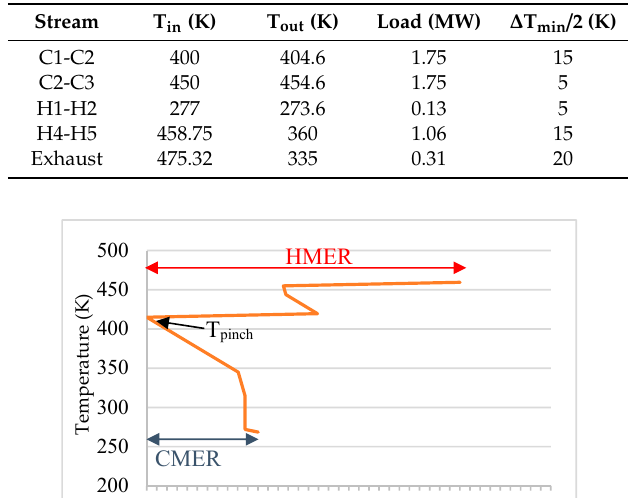
Table 3. Process streams data of the base case study